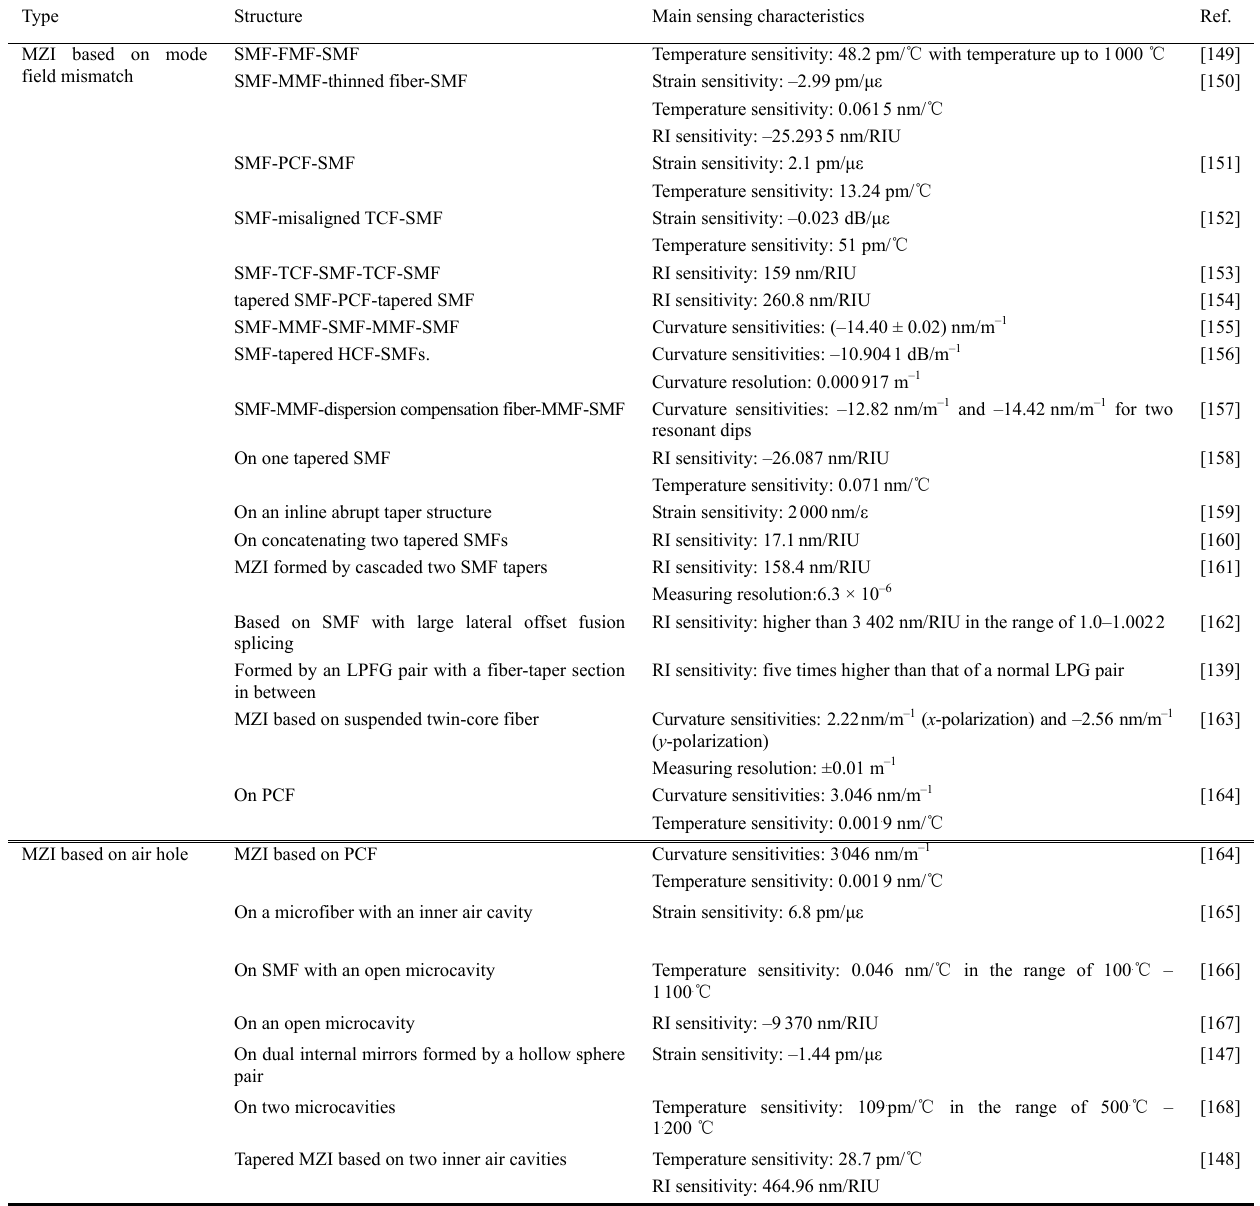
Table 6 Sensing characteristics comparison of different MZI-based FOM